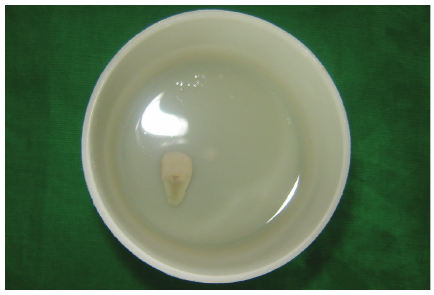
Figure 1: Preoperative view showing complicated crown-root fracture of maxillary right lateral incisor.